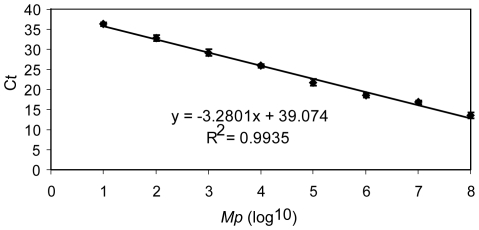
Quantitative detection of Mp in mouse lung by real-time PCR.A portion of the 16S rRNA (from nucleotides 201 to 265) that is specific for Mp was chosen as the molecular target for detection. Total RNA was purified from the lungs of one mouse, and RNA from the indicated number of Mp was added. 100 ng of total RNA was used for each real-time PCR reaction. Ct, cycle threshold. The sensitivity and linearity of the assay were confirmed in one additional experiment. Data shown are means ± SEM.